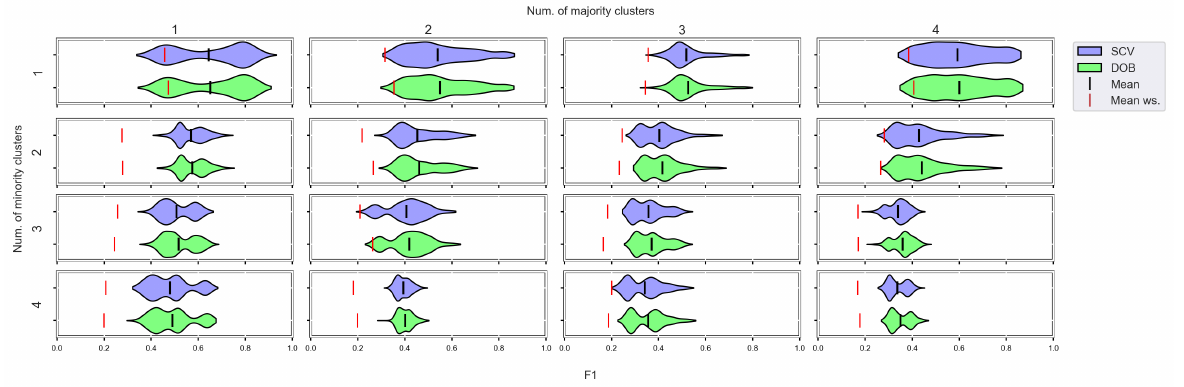
Figure 9. F 1 values concerning the number of clusters in the minority and majority classes in the case of the MLP classifier. (IR8).